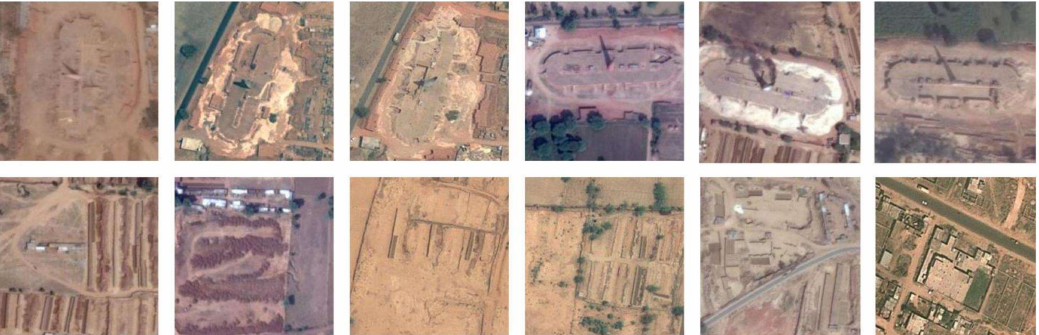
Figure 4. Examples of training samples used in the convolution neural networks (CNN) analysis. The top row of images shows examples with brick kilns while the bottom row shows non-kilns samples. Image data shown from Google Earth provided by Digital